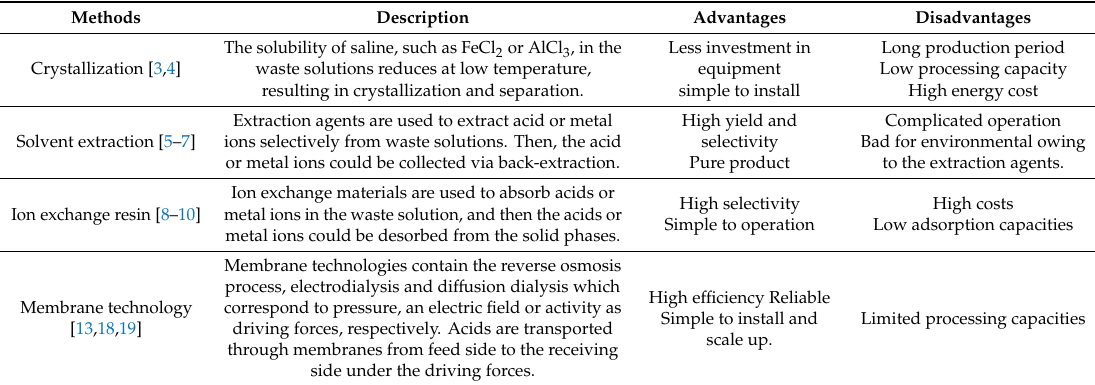
Table 1. A summary of methods for acid